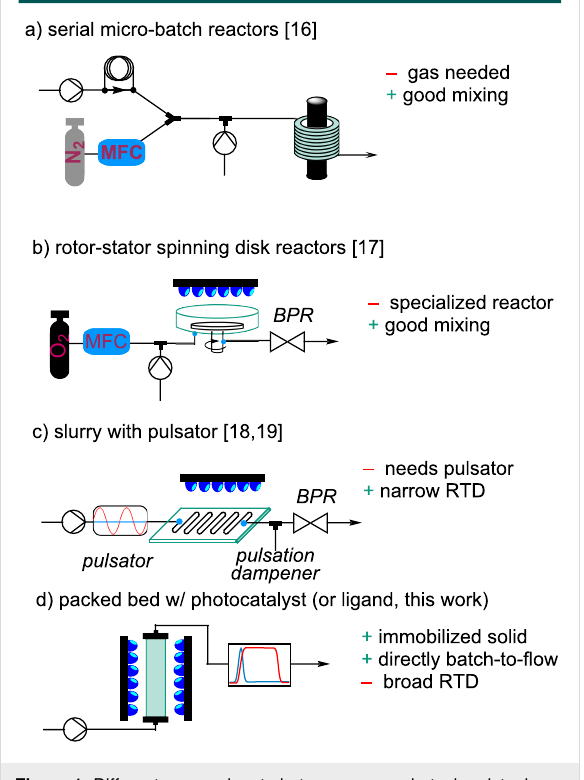
Figure 1: Different approaches to heterogeneous photochemistry in flow. a) Serial micro-batch reactors (SMBR), b) rotor-stator spinning disk reactors, c) slurry with pulsator, d) packed